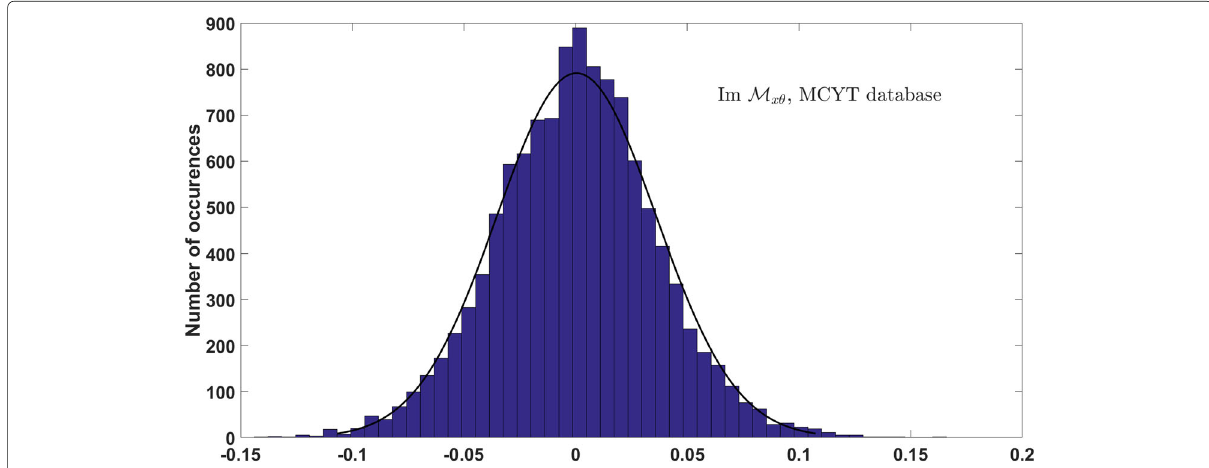
Fig. 5 Histogram of Im M x θ , and a fitted